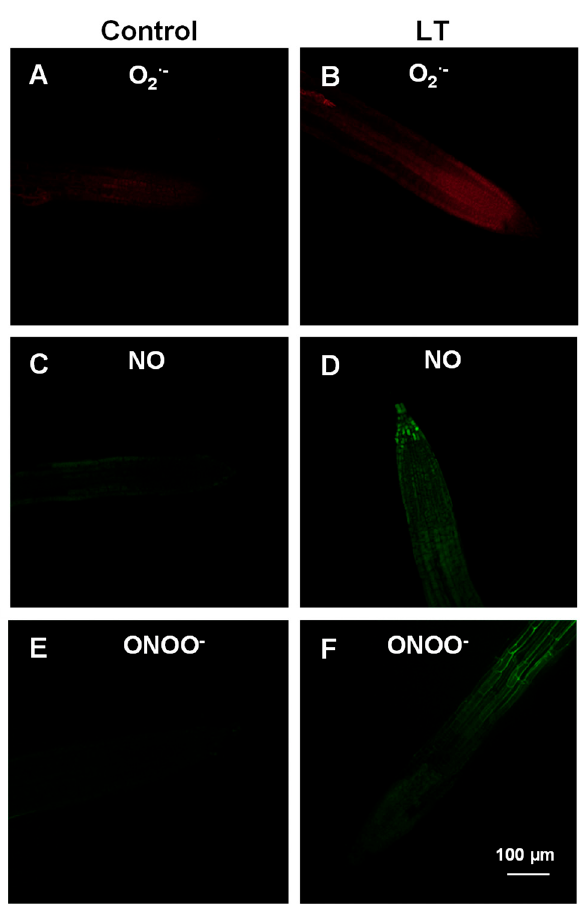
Figure 3. Fluorescence and confocal images showing the in vivo detection of superoxide radical (O 2 •− ) (panels A and B ), nitric oxide (NO) (panels C and D ), and peroxynitrite (ONOO − ) (panels E and F ) in Arabidopsis root tips after exposing seedlings to low temperature (LT) for 48 h.